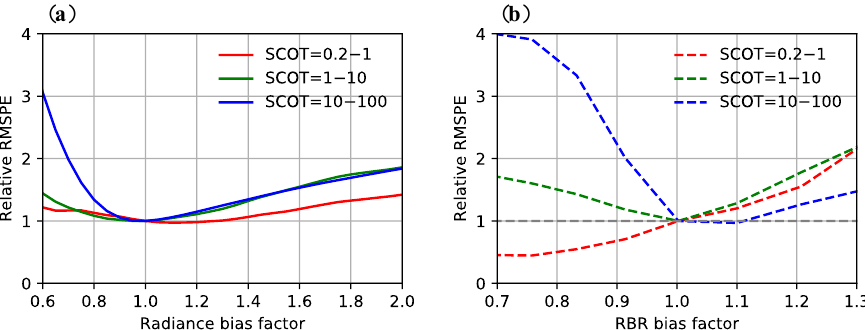
Figure 12. Sensitivities of the SCOT estimation error to ( a ) radiance bias and ( b ) RBR bias. The vertical axis is the RMSPE relative to the RMSPE, without radiance and RBR bias. For ( a ), the radiance bias with the same factor was assumed for all of the RGB channels. For ( b ), the biases of the red and blue channels are assumed to have opposite signs. A total of 100 samples from the test dataset were used to evaluate each case of biased input.